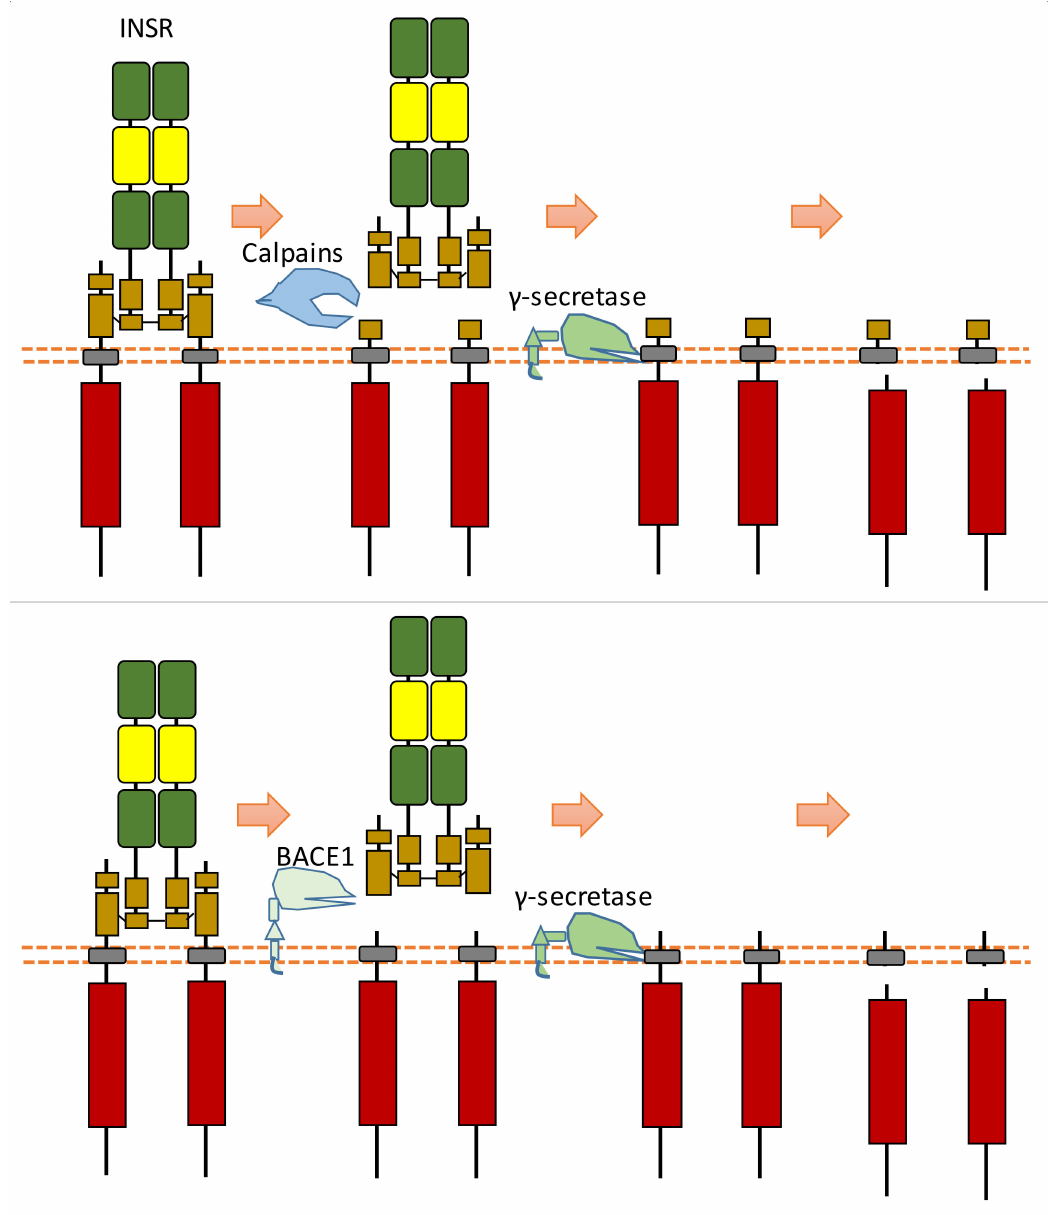
Figure 15. Schematic illustration of proteolytic cleavage in